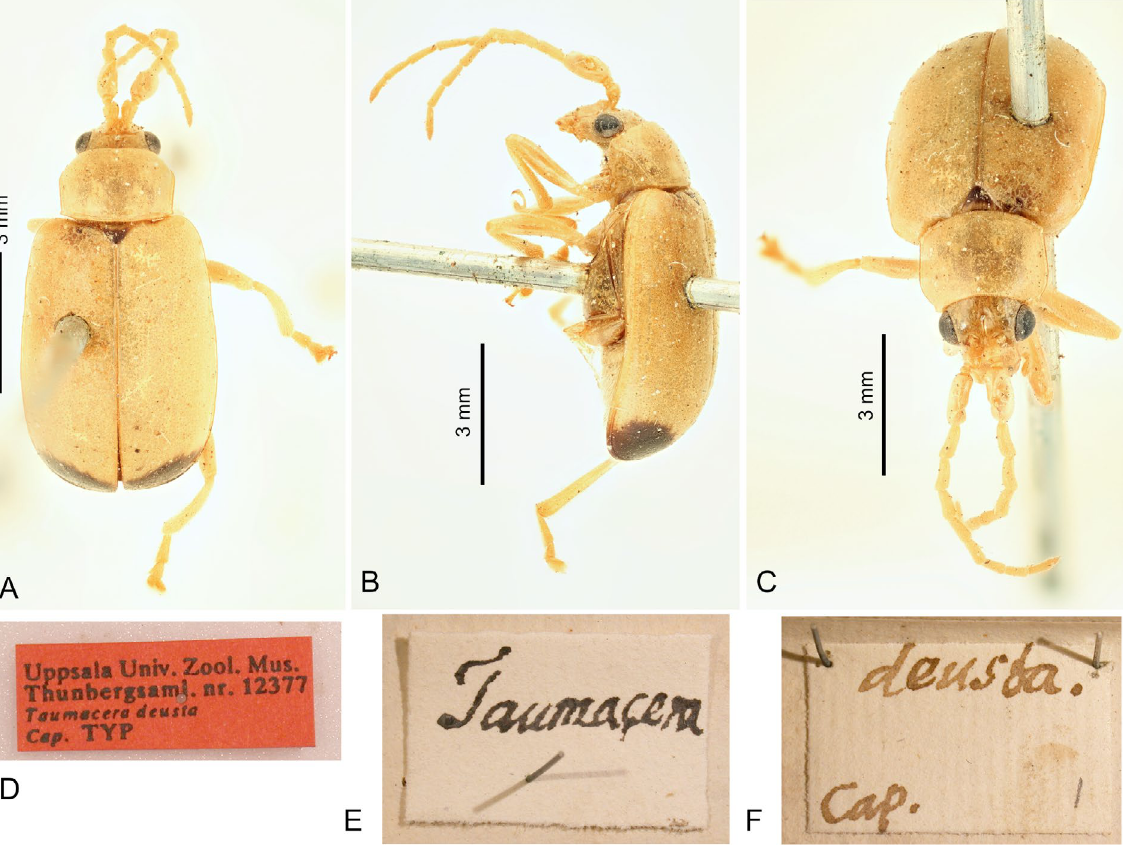
Fig. 18. Taumacera deusta Thunberg, 1814, holotype, ♂, 7.5 mm, UUZM. A . Dorsal view. B . Lateral view. C . Frontal view. D . Label. E . Box label 1. F . Box label